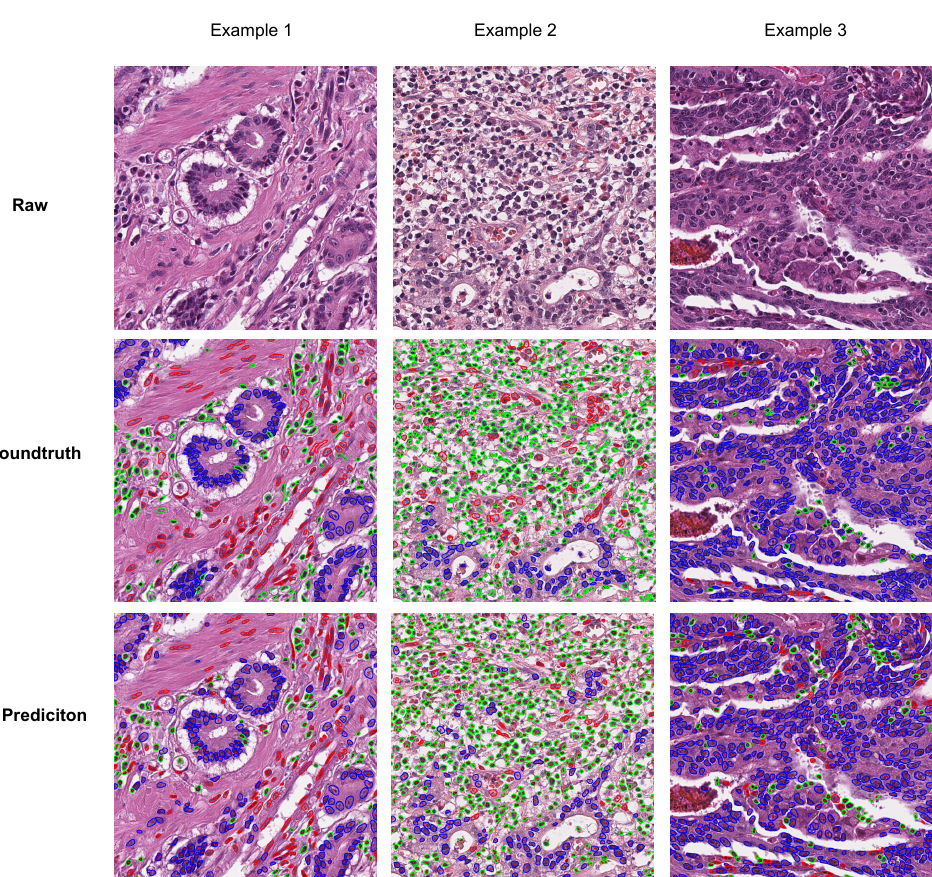
Figure 3. Sample tissue images from the GlySAC dataset with ground-truth annotations and predic- tion of Mulvernet